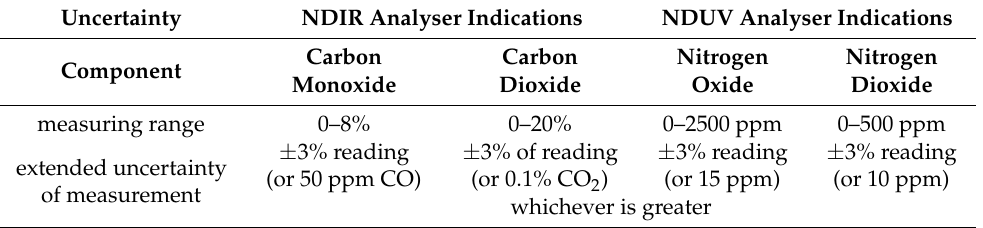
Table 3. Uncertainty of indications of individual measurement modules of the Semtech DS analyzer.